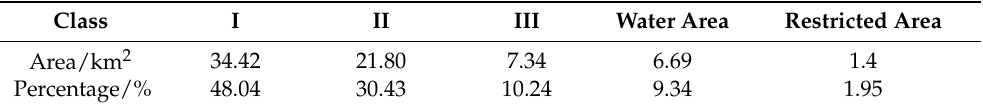
Figure 5. Evaluation results of UUS suitability in the starting area of Wuhan Changjiang New Town. Table 7. Summary of suitability evaluation results of underground